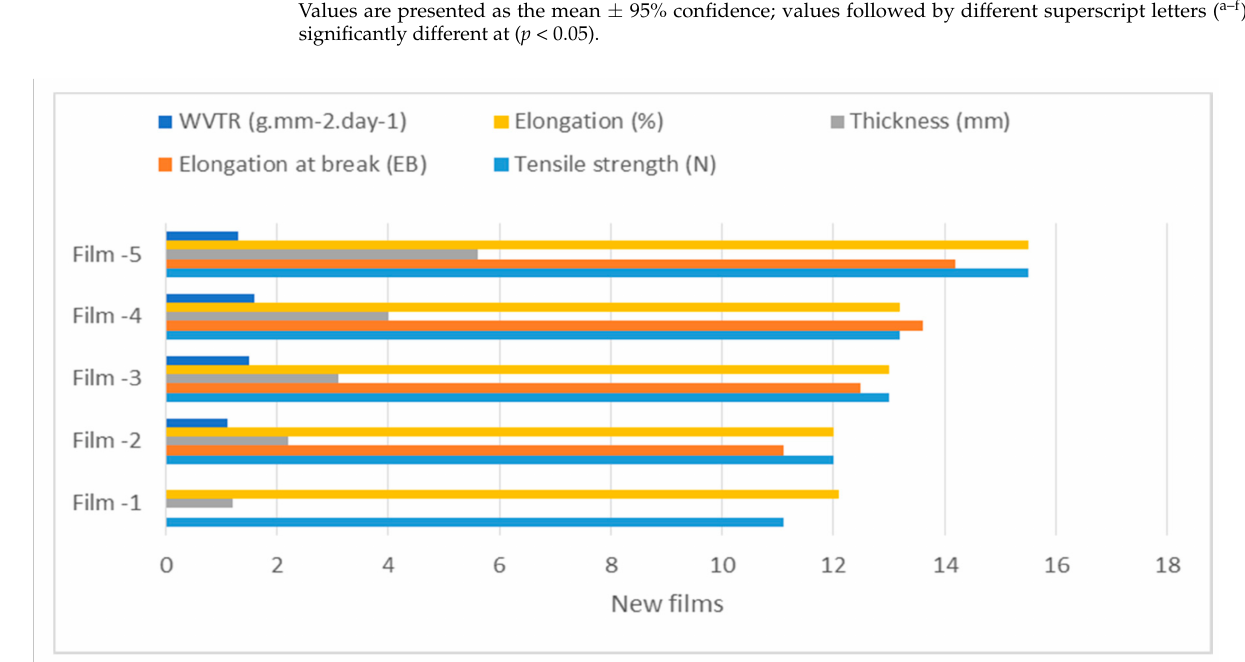
Figure 3. Mechanical and structural changes in films.